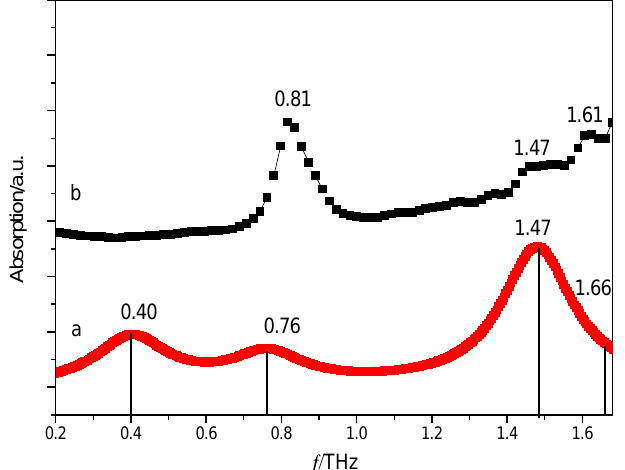
Figure 3. Comparison of THz spectra between simulated ( a ) and experimental ( b ) results of PZA and 3-hBA.